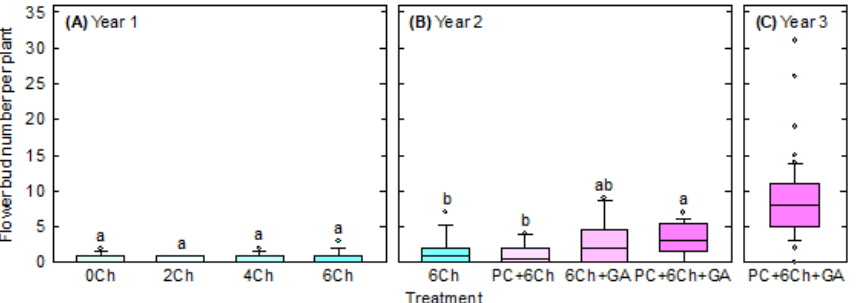
Figure 5. Number of flower buds per peony plant in ( A ) Year 1, ( B ) Year 2 and ( C ) Year 3. ‘0Ch’, ‘2Ch’, ‘4Ch’ and ‘6Ch’ = 0, 2, 4 or 6 weeks of chilling at 4 °C, respectively; ‘PC’ = pre-treatment from 20 °C to 8 °C prior to chilling; ‘GA’ = GA 3 treatment after chilling. Medians are presented with 25th and 75th percentiles (boxes), 10th and 90th percentiles (whiskers), and outliers (circles). Medians in the same year with different letters are significantly different (Kruskal–Wallis and Dunn’s tests with Bonferroni corrections; p < 0.05, n = 18–65).